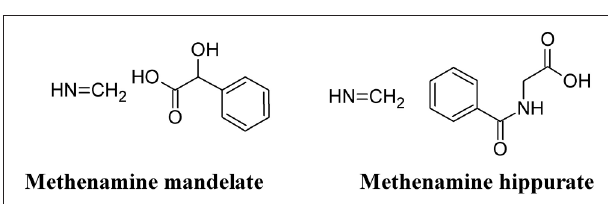
FIGURE 8 | Structure formulae of methenamine mandelate and